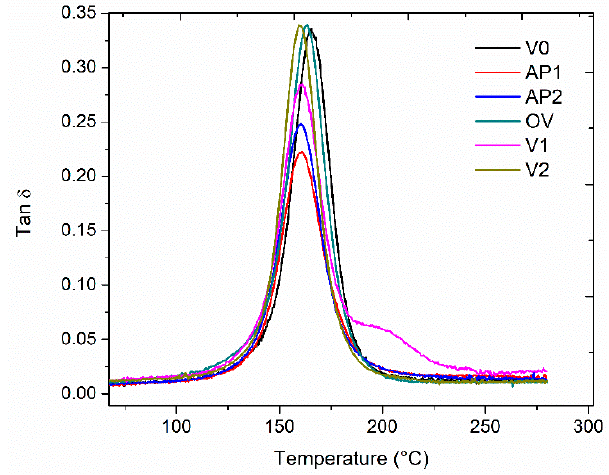
Figure 4. Tan δ versus temperature for the modified composites.